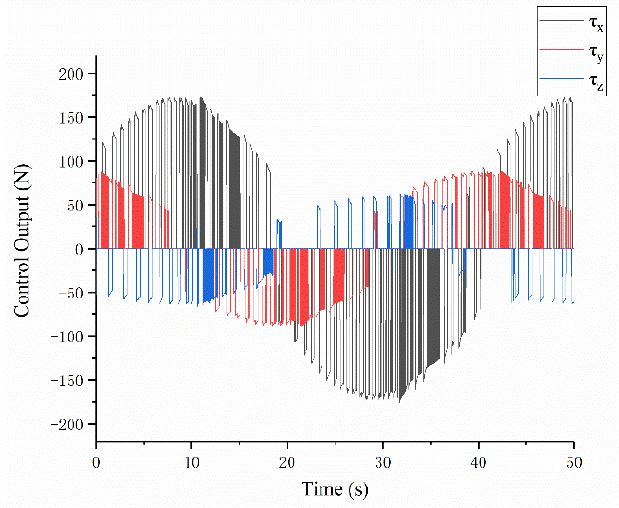
Figure 8. Control output of PRTC scheme.